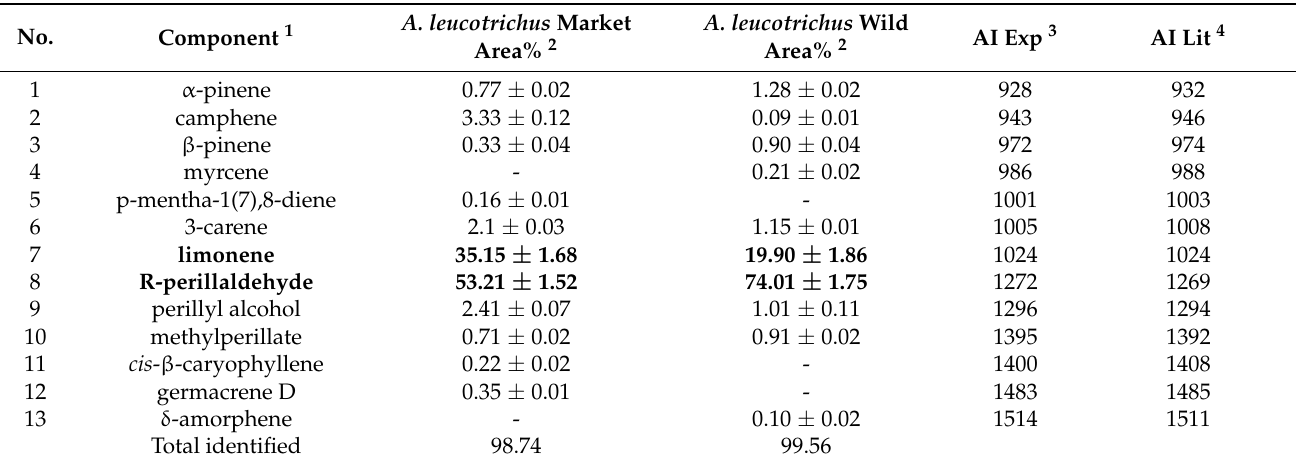
Table 4. Essential oil composition of A. leucotrichus